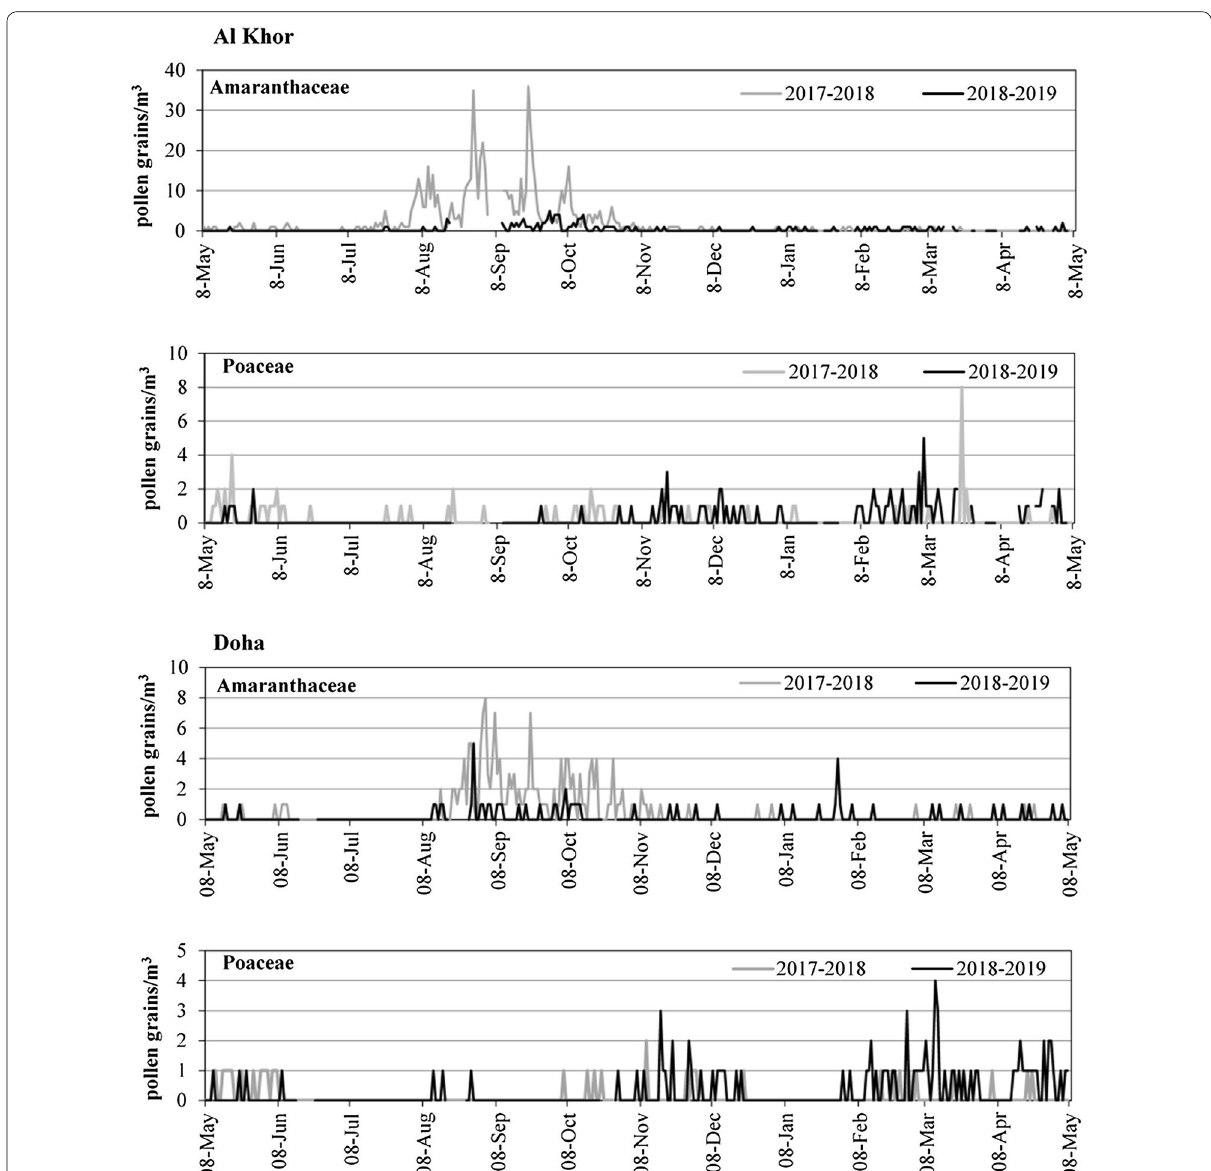
Fig. 2 Seasonal variation of the daily mean concentration (pollen grain/m 3 ) of the two main pollen (Amaranthaceae and Poaceae) in the aerobiological sampling sites Doha and Al Khor. Higher airborne pollen concentration was detected in the atmosphere of Qatar in the